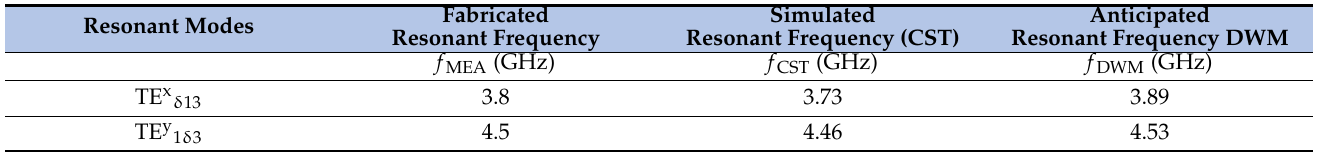
Figure 15. Gain of the proposed antenna.